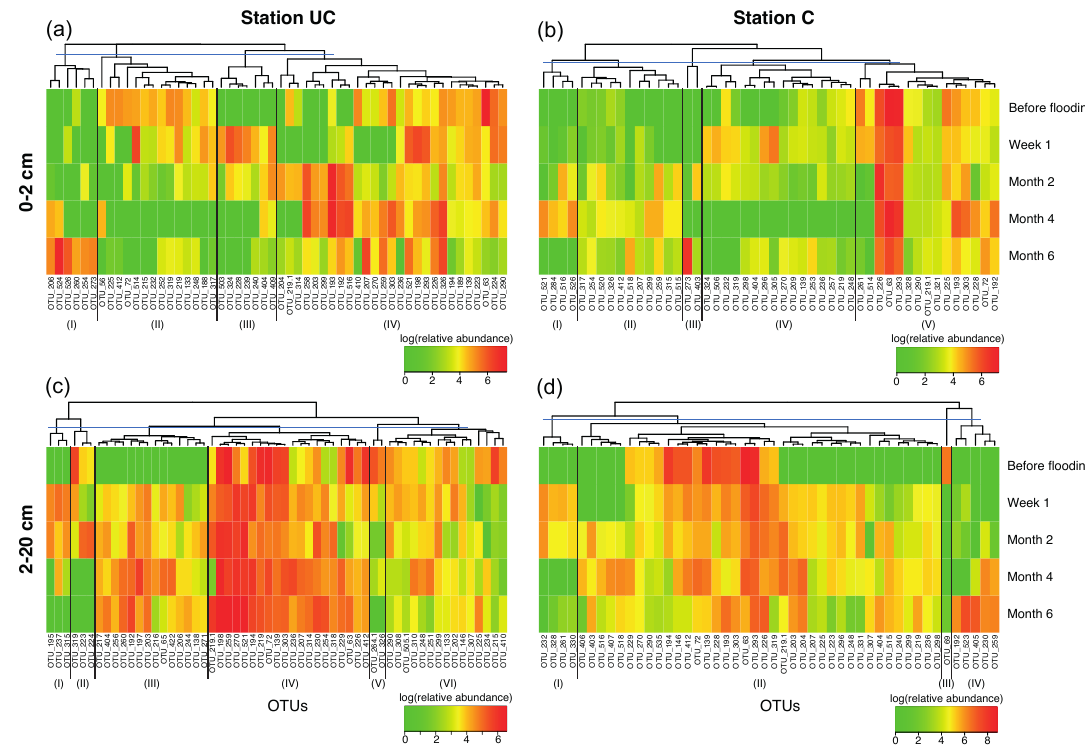
Figure 8. Heatmaps illustrating log transformed relative abundances of OTUs present at greater than 3% in: ( a , b ) soils at 0–2; and ( c , d ) 2–20 cm depth for the uncultivated (UC) and cultivated (C) stations at each sampling time point. Major modules of OTUs with similar abundance patterns were emphasized and numbered for each